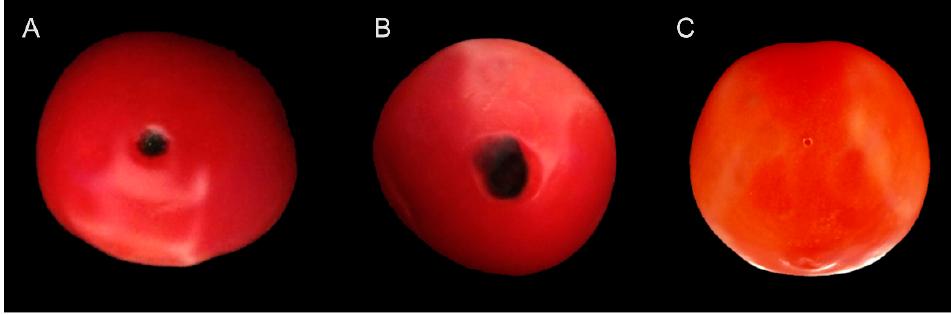
Figure 4. Pathogenicity of Colletotrichum truncatum on tomato fruits after 7 days of inoculation.